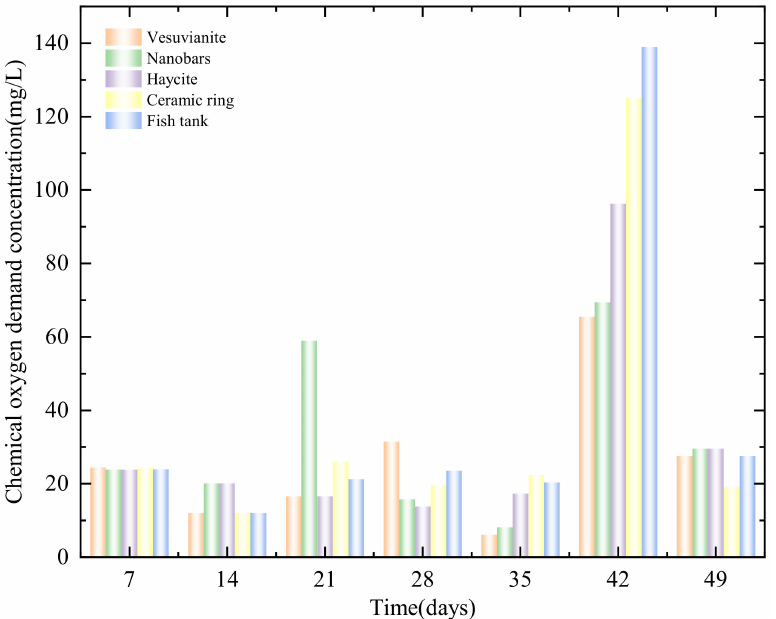
Figure 3. Changes in the chemical oxygen demand in each filter tank and the fish